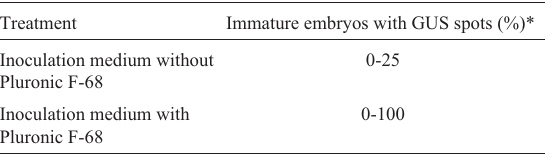
Table 4 - Effect of the addition of 0.03% (w/v) Pluronic F-68 to the inoculation medium on transient GUS expression in immature embryos. Treatment Immature embryos with GUS spots (%)* Inoculation medium without Pluronic F-68 Inoculation medium with Pluronic F-68 *Data from eight replicate experiments using 50 embryos per